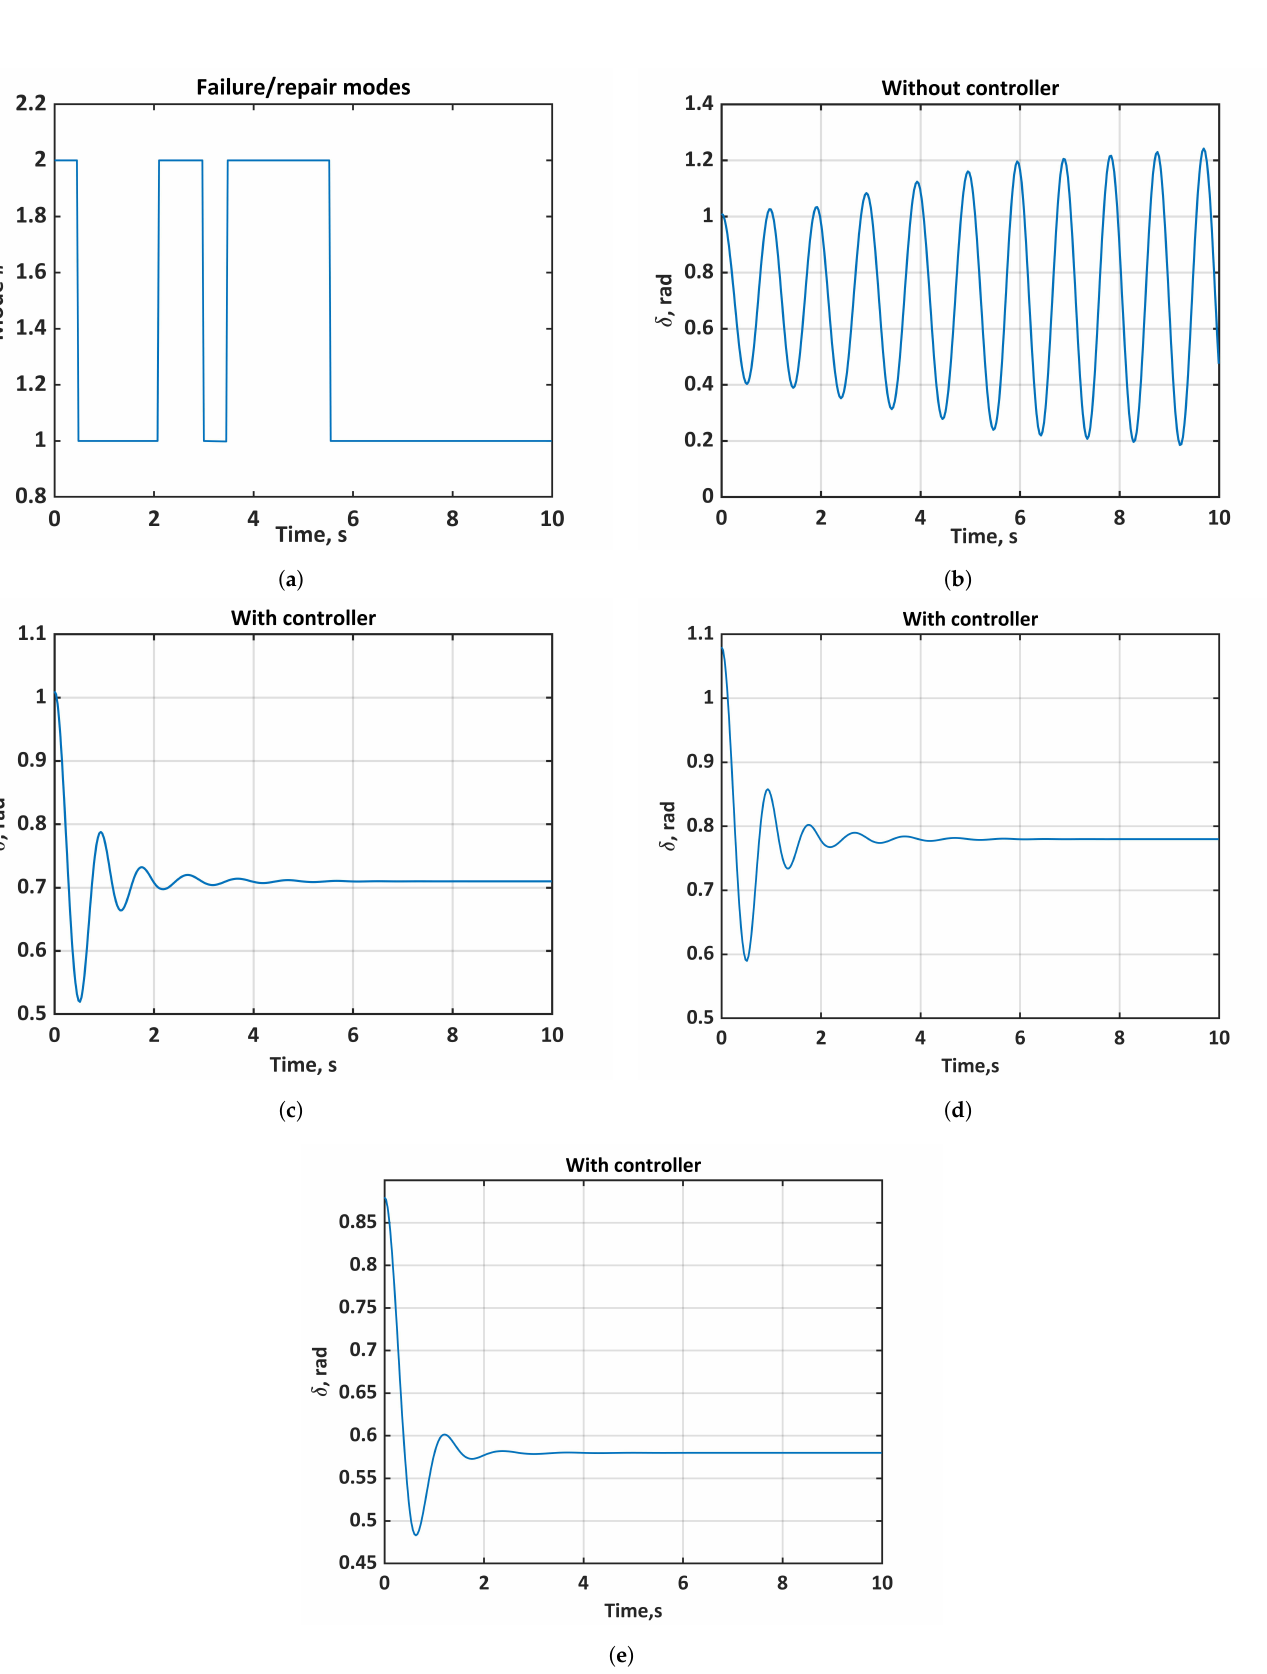
Figure 8. SMIB system response subject to random failure/repair modes under varying load conditions, such as ( a ) Random failure/repair modes ( b ) Open-loop response ( c ) Closed-loop response at the nominal load ( d ) Closed-loop response at the heavy load ( e ) Closed-loop response at the light